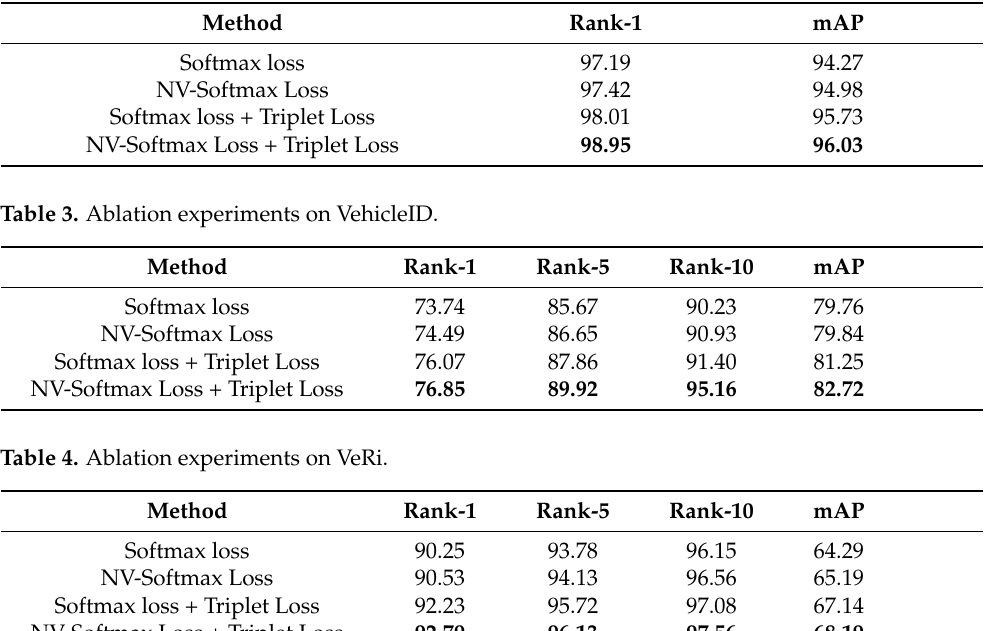
Table 2. Ablation experiments on VRAI-AIR.